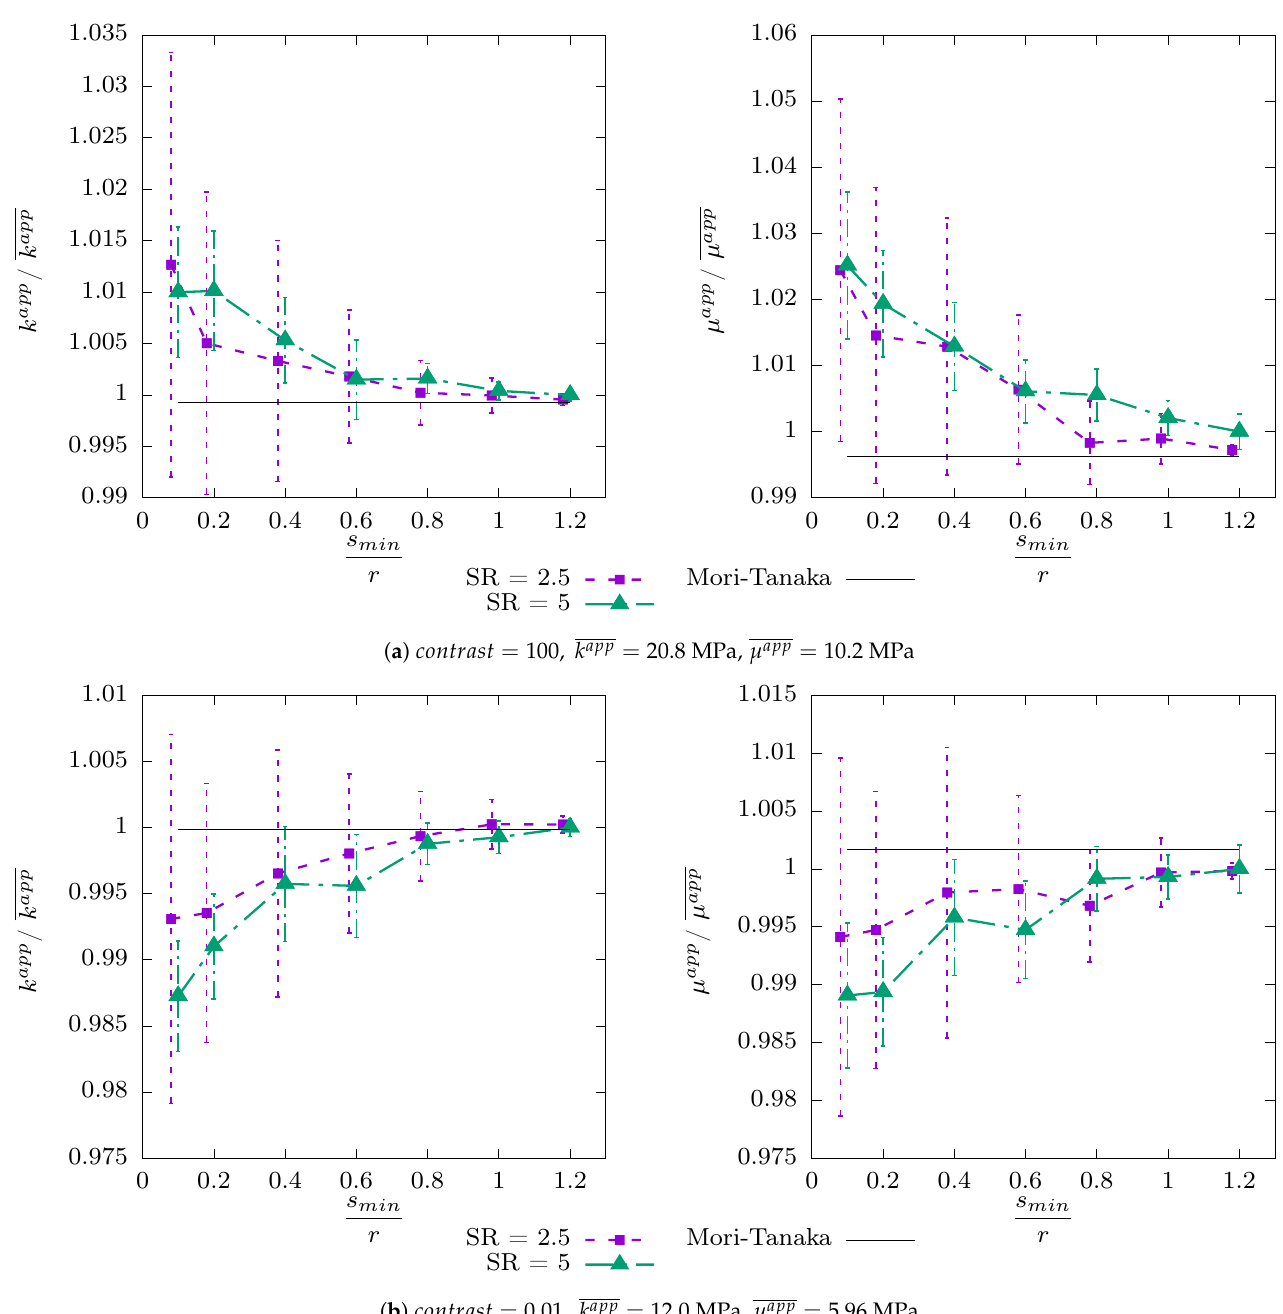
Figure A2. Mean values and standard deviations on the mean value for the apparent moduli as a function of the packing parameter s min / r ( r = 5 µ m) for a volume fraction of inclusions f v = 13.4 %. For clarity, the error bars and dots are slightly shifted around for each studied minimum